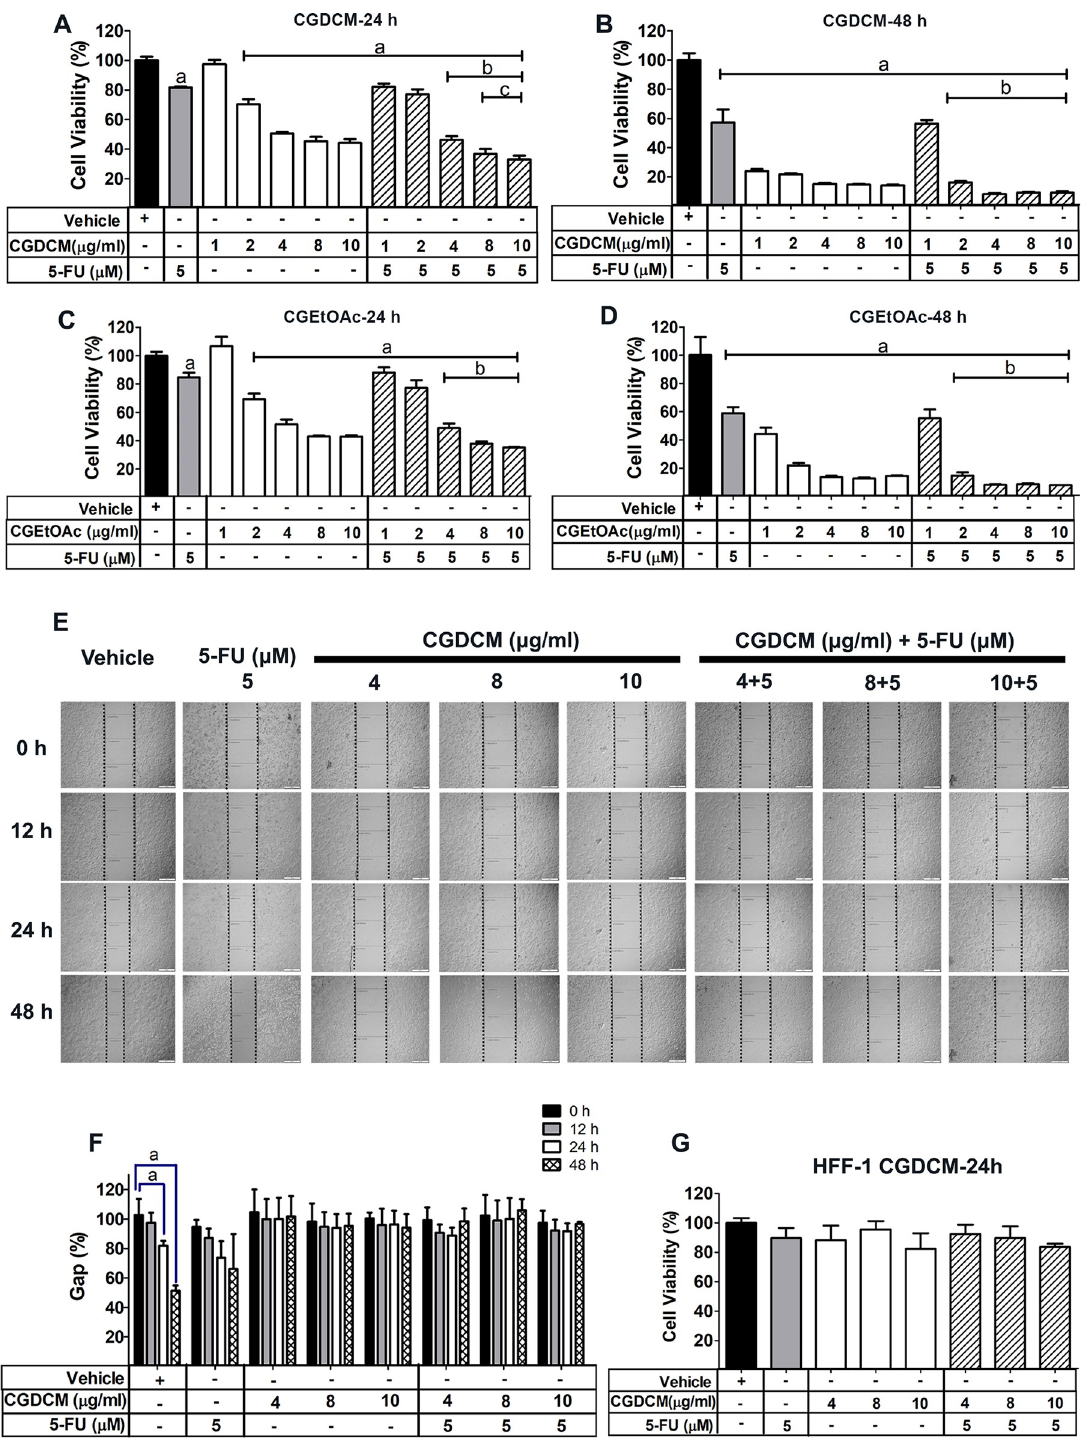
Fig 2. Combination effects of Calotropis gigantea stem bark extracts and 5-FU on cytotoxicity in HCT116 cells. The viability of HCT116 cells was analyzed in an MTT assay for 24 h ( A ) and 48 h ( B ), following treatment with CGDCM (with/without 5-FU), and for 24 h ( C ) and 48 h ( D ), following treatment with CGEtOAc (with/without 5-FU). Anti-proliferative and anti-migration activities of CGDCM and 5-FU were evaluated in a wound healing assay for 48 h; bars = 500 μ m ( E and F ). Data are presented as mean ± SD. Cytotoxicity was evaluated in HFF-1 cells for 24 h ( G ). The data were analyzed by one-way ANOVA with Tukey’s HSD test. a; p < 0.05 vs. vehicle group. b; p < 0.05 vs. 5-FU group. c; p < 0.05 vs. treatment with CG extract alone. Abbreviations: CGDCM, C . gigantea dichloromethane extract; CGEtOAc, C . gigantea ethyl acetate extract; 5-FU, 5-fluorouracil. https://doi.org/10.1371/journal.pone.0254392.g002 PLOS ONE | https://doi.org/10.1371/journal.pone.0254392 August 3,